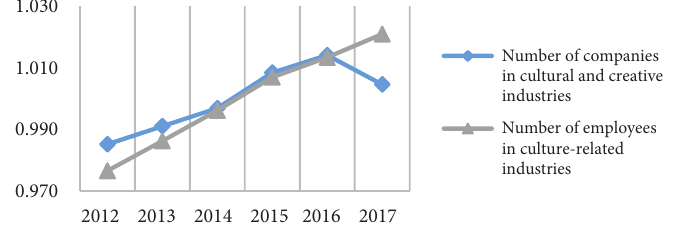
Figure 5. Cultural and industrial